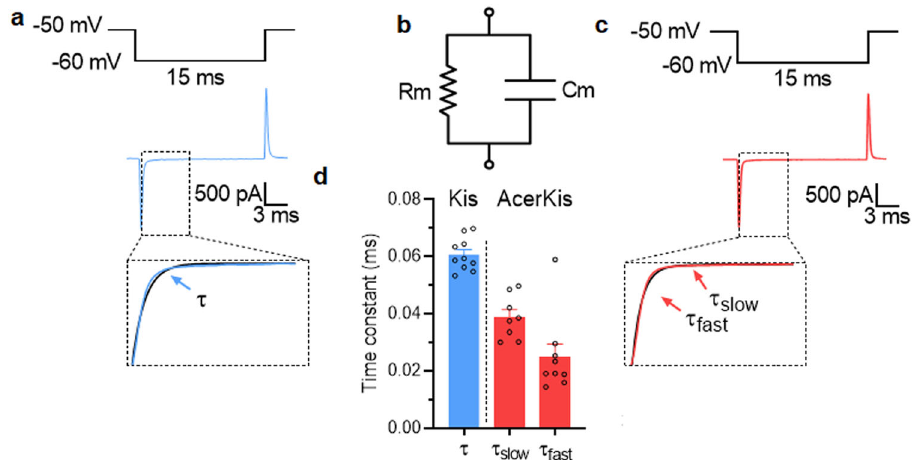
Fig. 3 Total membrane capacitance measurement in isolated neurons from Kis and AcerKis Anopheles gambiae strains. a – c Typical examples of the capacitive current transients were recorded under voltage-clamp condition at a holding potential of − 50 mV following a hyperpolarized voltage pulse according to the protocols indicated above each trace in Kis ( a ) and AcerKis ( c ) neurons. ( b ) represents the reduced equivalent circuit of the neuron cell body plasma membrane obtained by combining a fi xed capacitance (Cm) in parallel with ion-speci fi c pathway (Rm). The decay phase of the transient was well- fi tted with a single exponential in Kis neurons whereas two exponential functions were used to fi t the decay phase of the transient in AcerKis neurons giving fast and slow time constants (see text for details). d The corresponding comparative histogram illustrates the mean values of the time constants calculated for Kis and AcerKis neurons. Bars represent mean ± S.E.M. ( n = 9 – 10). The number of experiments ( n ) are biologically independent